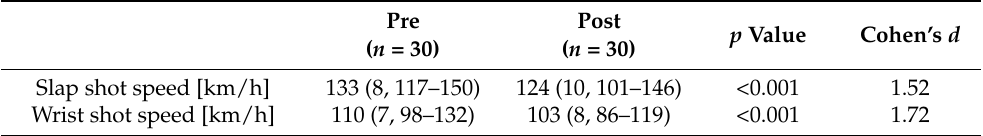
Table 3. Maximum shooting speed of successful goal shots before and after the IHCT. Values presented as mean (one standard deviation, minimum and